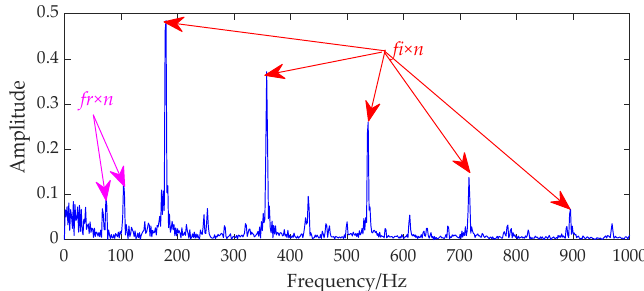
Figure 12. The results for modes 1 and 4 are processed by CLNGO-MNAD.